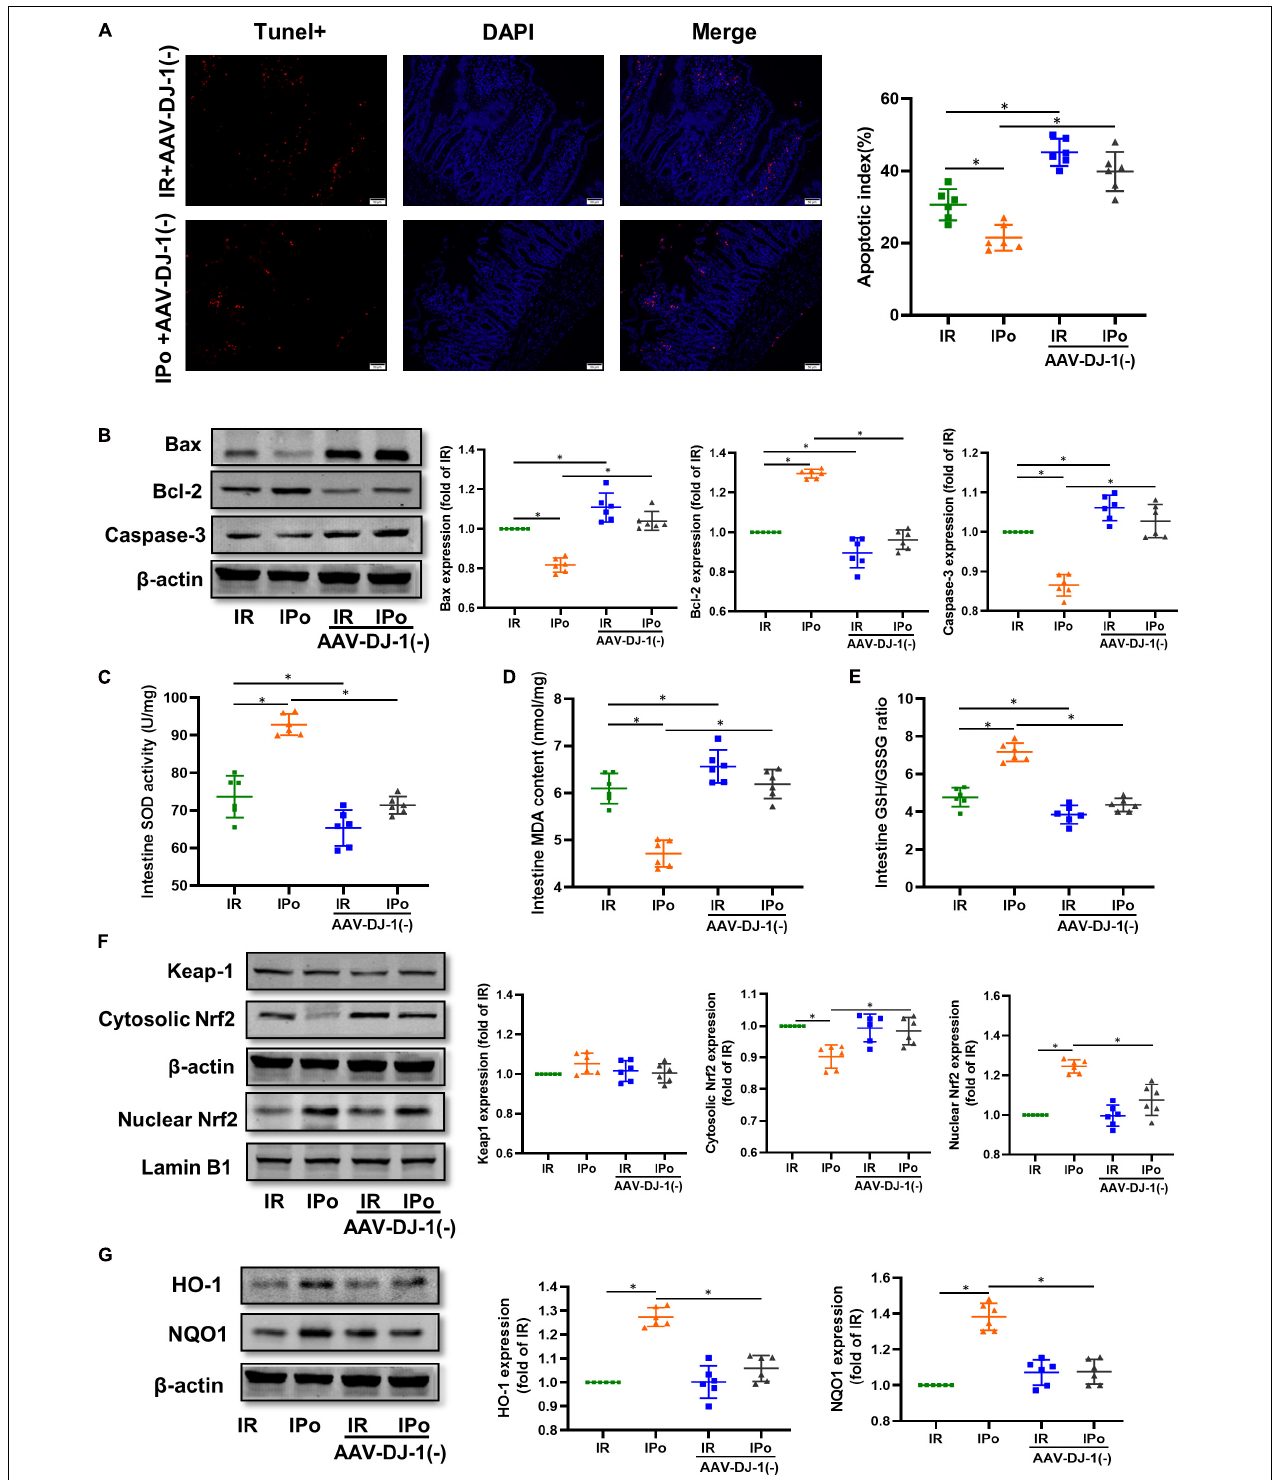
FIGURE 8 | Knockdown of DJ-1 abrogated IPo-induced protection via ameliorated myocardial IR-induced apoptosis and suppressed oxidative stress by regulating Nrf2 pathway. (A) The TUNEL staining for cell apoptosis rates. (B) Expression of apoptosis-related proteins Bax, Bcl-2 and Caspase-3. (C) SOD. (D) MDA. (E) GSH/GSSG ratio. (F) Expression of Keap-1, Nrf2 in the cytosolic and nucleus, (G) Expression of HO-1 and NQO1. Lamin B1, β -action were detected as loading controls, respectively, and β -action gel is the same as in Figure 7 . S, Sham; IR, ischemia reperfusion; IPo, ischemic postconditioning. Data are presented as the mean ± SD ( n = 6). * P <